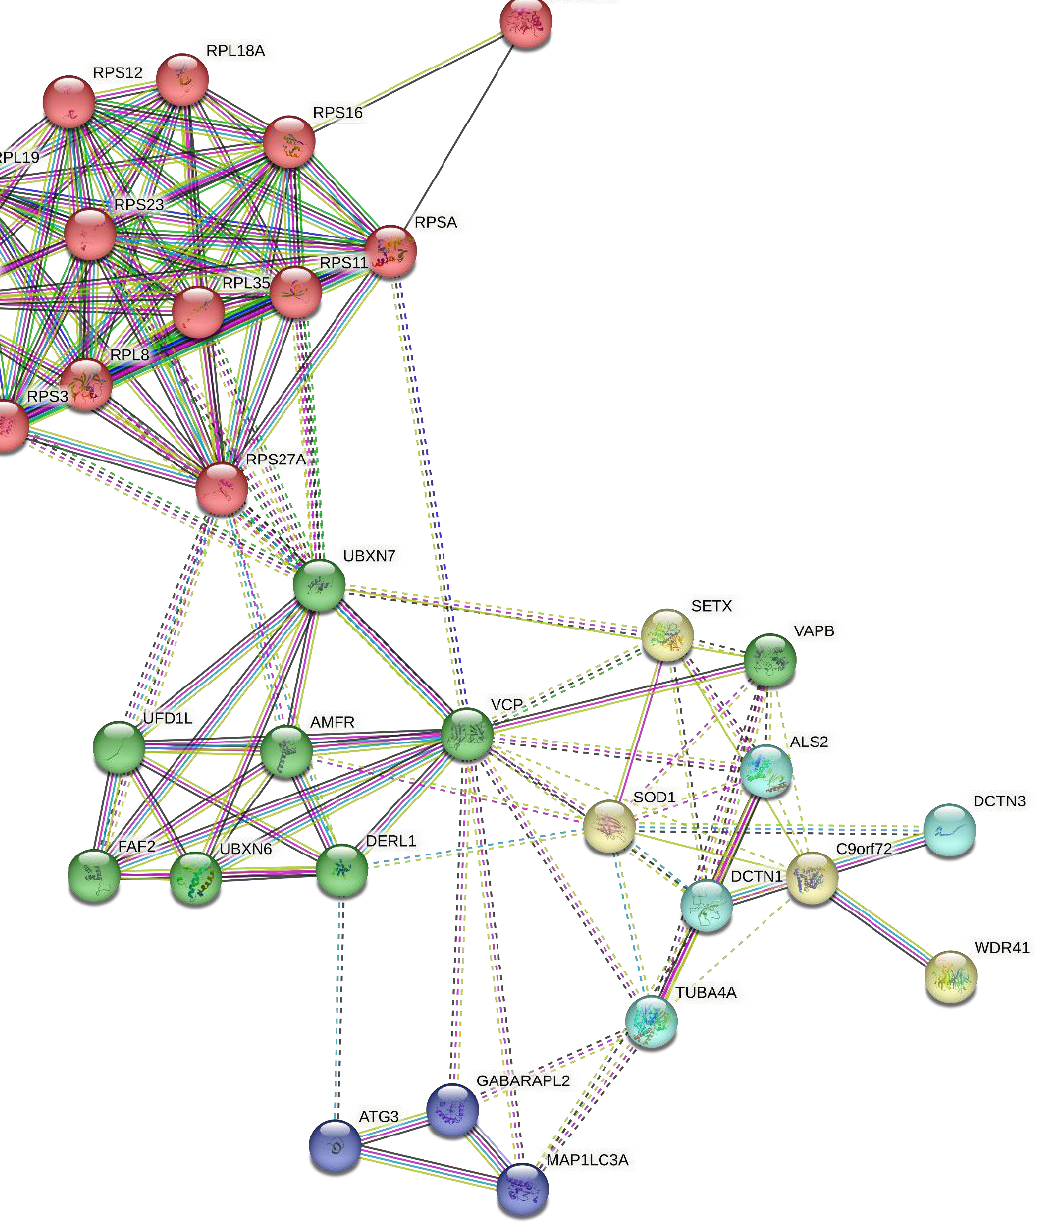
Figure 3. Threefold expanded protein-protein interactions of 12 selected ALS-associated genes (RPSA, MAP1LC3A, GABARAPL2, SOD1, ALS2, VAPB, TUBA4A, DCTN1, SETX, C9orf72, VCP, and HNRNPL), visualized with k-mean clustering into five clusters. Legend: Cluster 1: red (HNRNPL, RPL18A, RPL19, RPL35, RPL37, RPL8, RPS11, RPS12, RPS16, RPS23, RPS27A, RPS3, and RPSA). Cluster 2: yellow (C9orf72, SETX, SOD1, and WDR41). Cluster 3: green (AMFR, DERL1, FAF2, UBXN6, UBXN7, UFD1L, VAPB, and VCP). Cluster 4: cyan (ALS2, DCTN1, DCTN3, and TUBA4A). Cluster 5: blue (ATG3, GABARAPL2, and MAP1LC3A). Dotted lines show inter-cluster interactions.